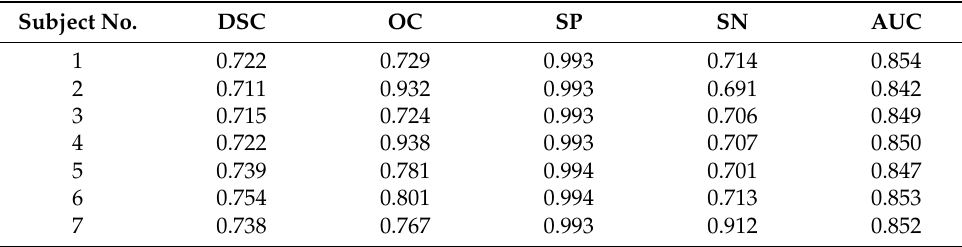
Table A7. Evaluation results for cerebellar fissures (model M1) on BrainWeb